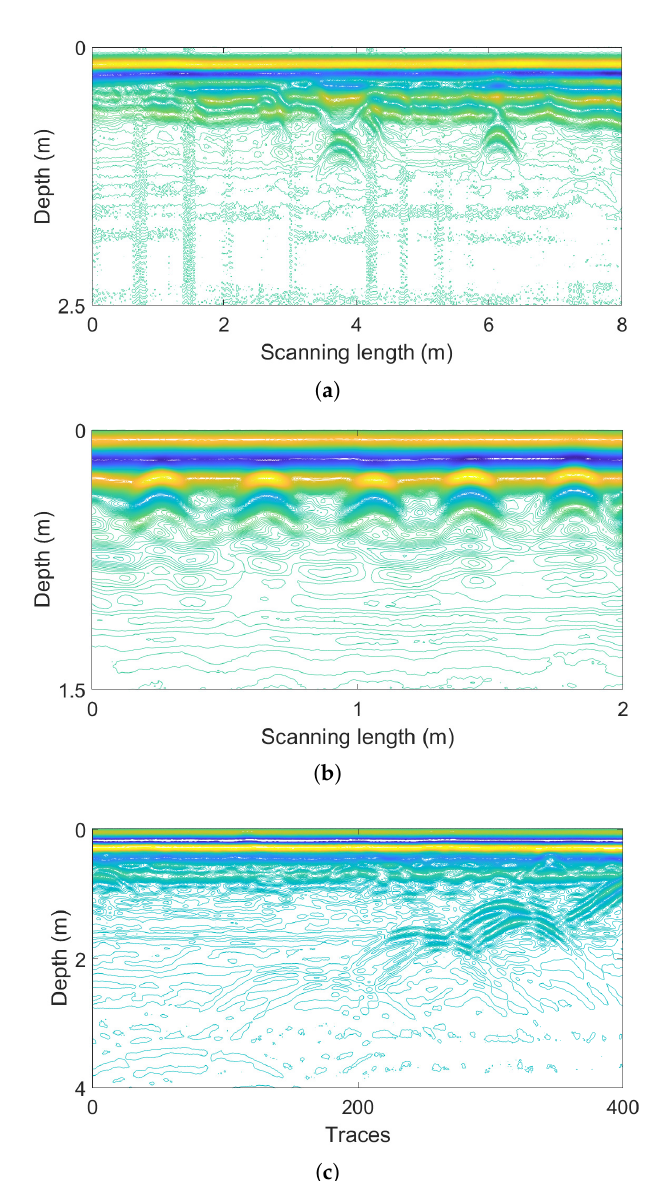
Figure 2. Field GPR profiles of ( a ) two separate pre-buried pipelines, ( b ) double-layer concrete cylinders, and ( c ) three distributed pipelines